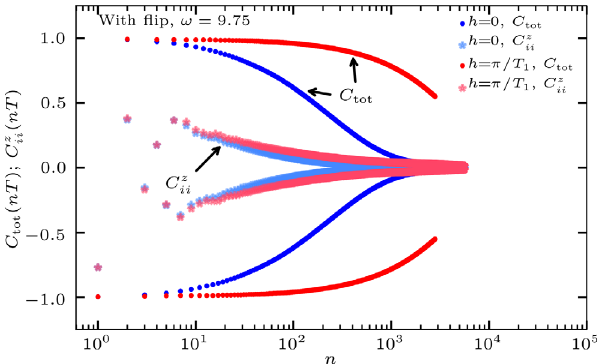
FIG. 5. Comparison between the survival of the global mag- nT Þ and the local correlation function C z netization C tot ð ð 1 = 2 L Þ Tr ½ Z i ð nT Þ Z i (cid:2) . The former can decay much more